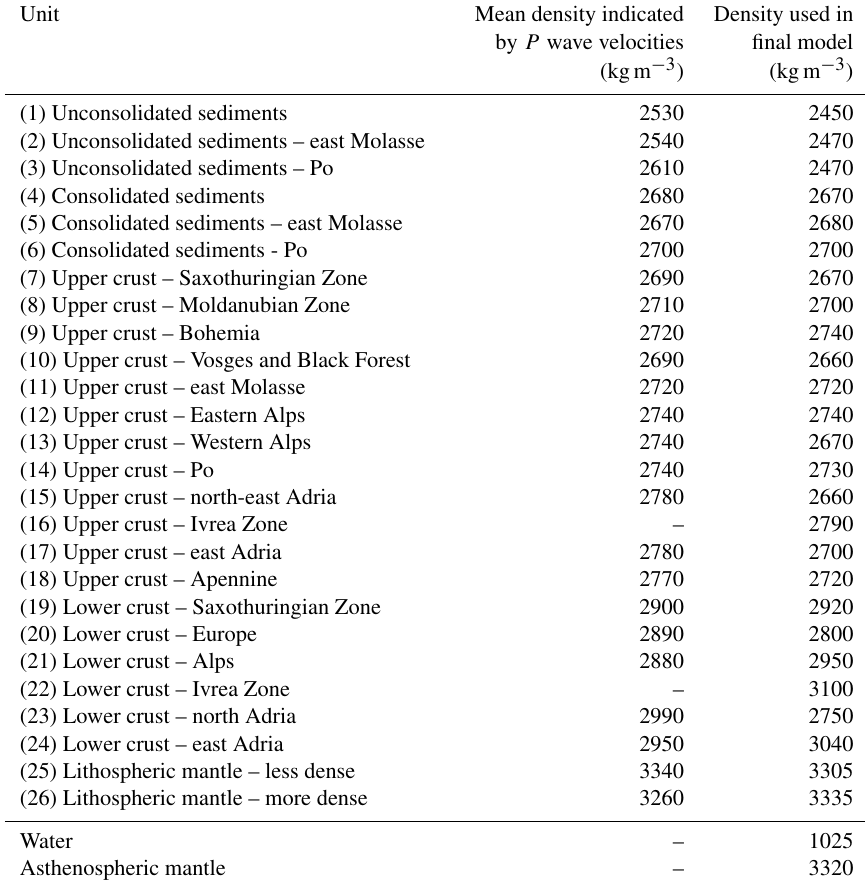
Table 1. The density of each domain in the model calculated by converting from its mean P wave velocity using the empirical relationship detailed in Brocher (2005) and the density of all domains used in the final model of the region that best reproduce the indications of both the seismic data sources and the gravity field. Locations of each density domain can be found in Fig.